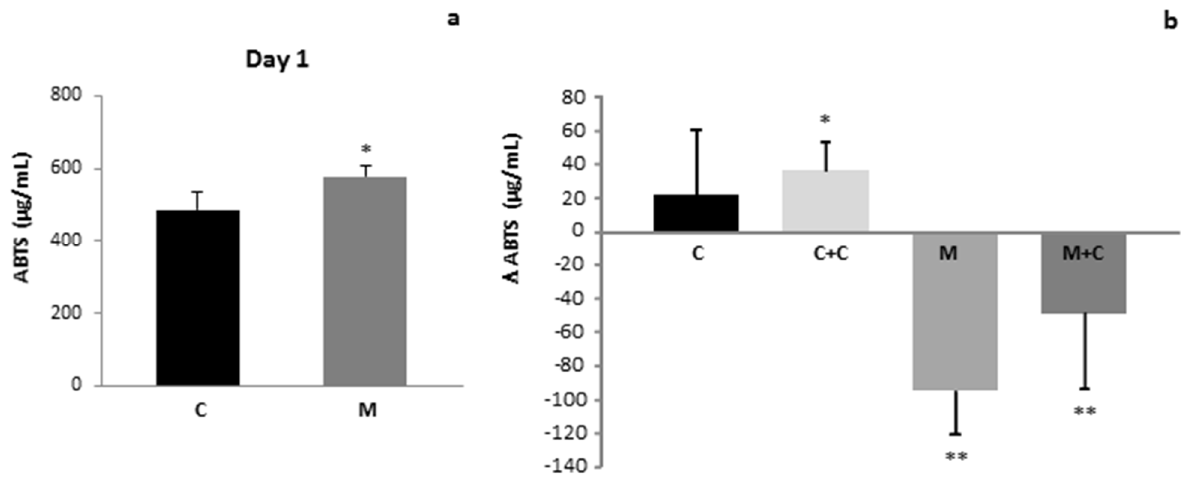
Figure 1. ( a ) Total antioxidant capacity of human milk of Control and Mastitis groups ( p < 0.05 vs. C). ( b ) Variation of total antioxidant capacity of human milk along the study of Control, Control + Cranberries, Mastitis and Mastitis + Cranberries groups. Control (C), Control + Cranberries (C + C), Mastitis (M) and Mastitis + Cranberries (M + C). * p < 0.05 vs M and M+C, ** p < 0.05 vs rest of groups.